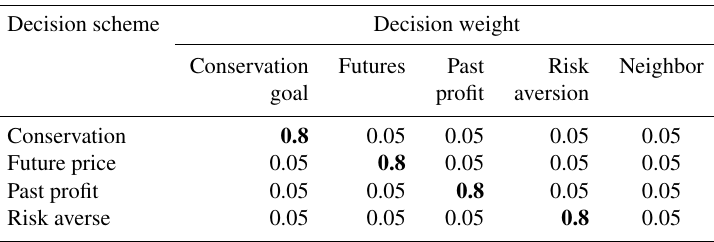
Figure 5. Squaw Creek watershed and subbasin division used in the hydrology module. Land cover data shown are from the National Land Cover Database (Dewitz, 2019). Table 3. Decision weighting scheme tested with each scenario. Bold numbers indicate the decision variable assigned 80% weight for each decision